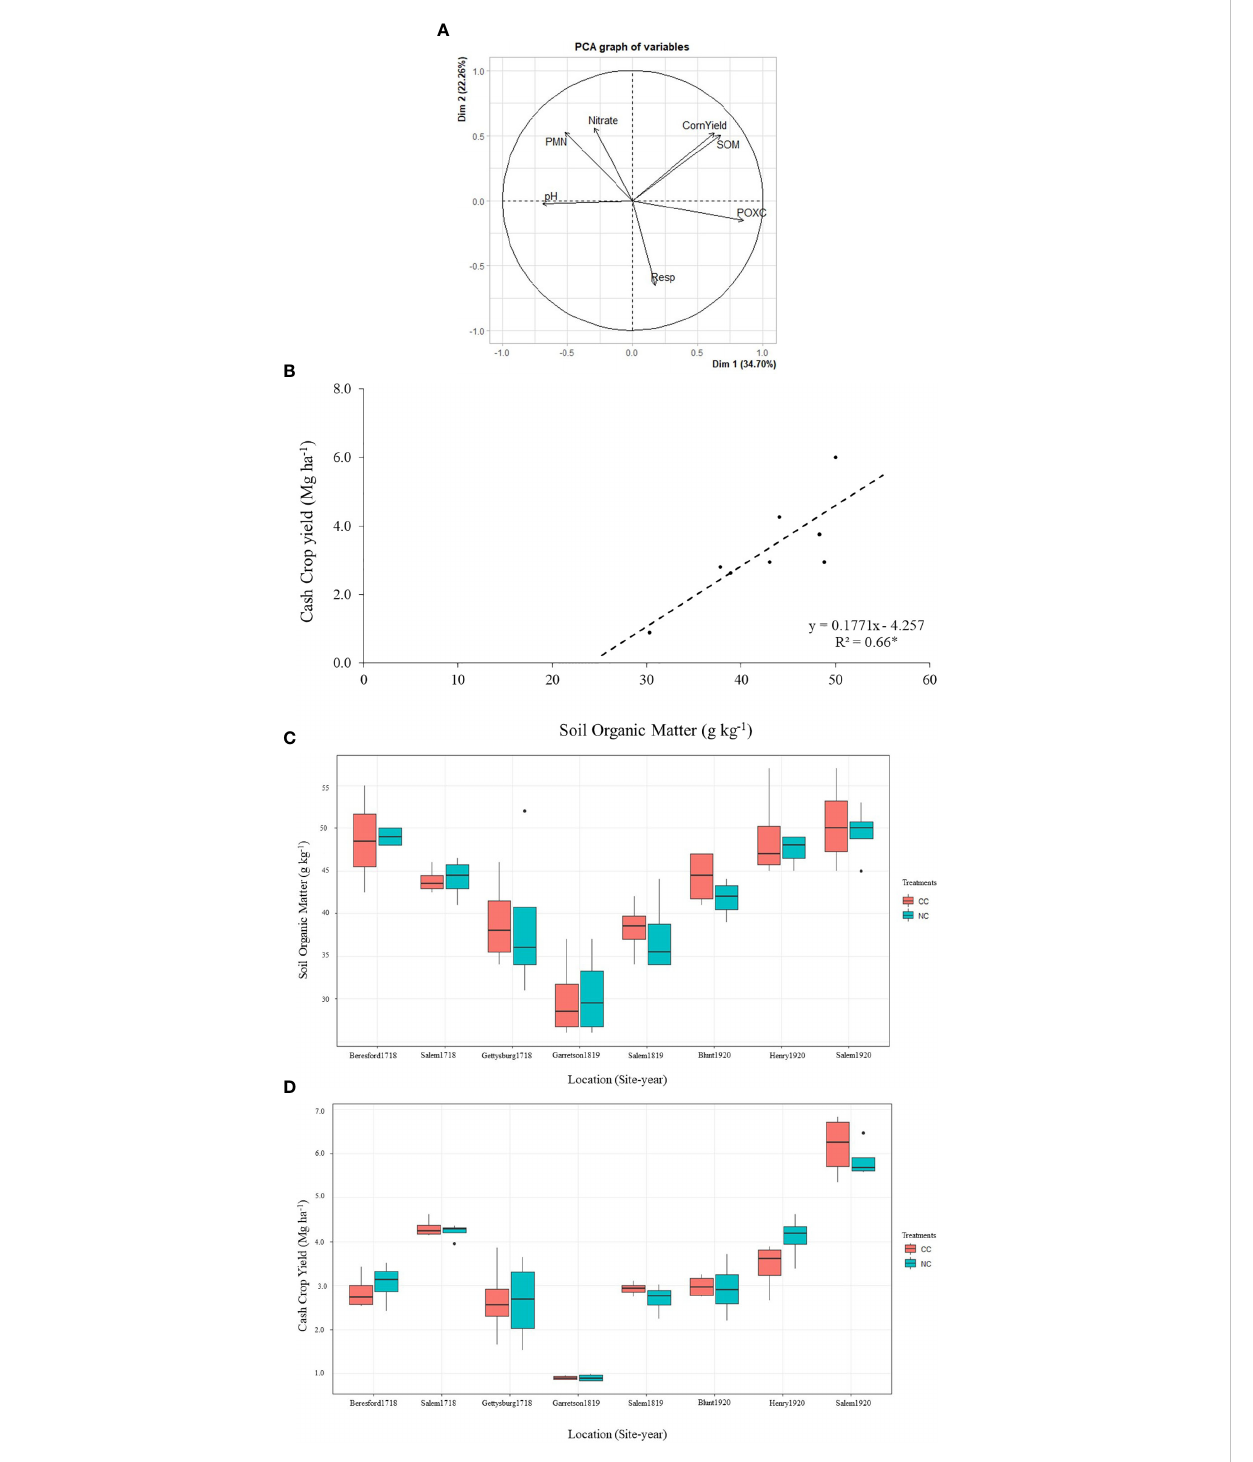
FIGURE 4 (A) Principal component analyses among selected soil parameters like soil pH, soil organic matter (SOM), nitrate-nitrogen (NO3¯-N), potentially mineralizable nitrogen (PMN), active carbon or permanganate oxidizable carbon (POX-C), soil respiration (SR), and cash crop yields (soybean at Garretson, SD 2018-2019, and corn at other locations; (B) Linear relationship between soil organic matter (SOM, g kg -1 ) and cash crop yield (Mg ha -1 ), (C) a boxplot depicting soil organic matter (SOM) status and (D) a boxplot showing cash crop yields (Mg ha -1 ) under the cover crop (CC) and no cover (NC) control plots at the research sites around South Dakota during 2018, 2019, and 2020